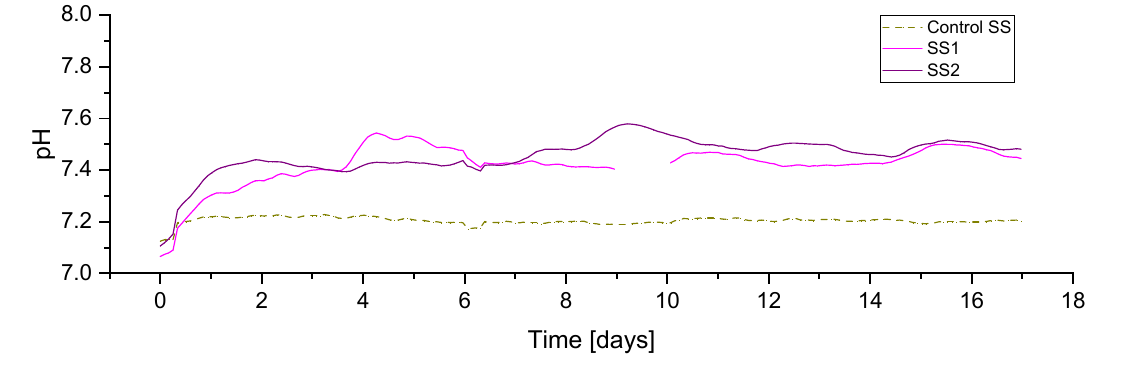
Figure 7. pH profile during period R1 for sewage sludge (SS) fed reactors.